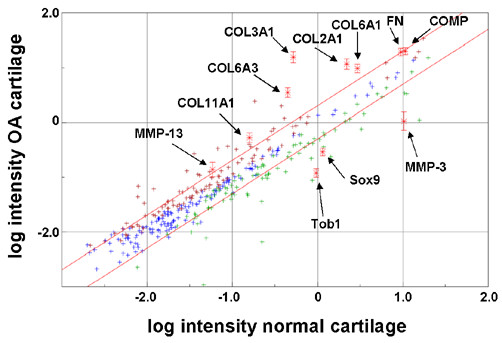
Plot of normalized logarithmic expression signal intensities RNAs from late osteoarthritic against the intensities for normal cartilage. RNA samples from 10 late-stage osteoarthritis patients were hybridized in comparison with normal cartilage (pool of nine donors) on SensiChip microarrays. After normalization, expression data were merged and corresponding signal intensities of late-stage osteoarthritis patients and normal cartilage were plotted against each other. Several differentially expressed marker genes (P < 0.01) are highlighted and diagonal lines indicate a twofold regulation. Error bars show standard deviations of ratios.